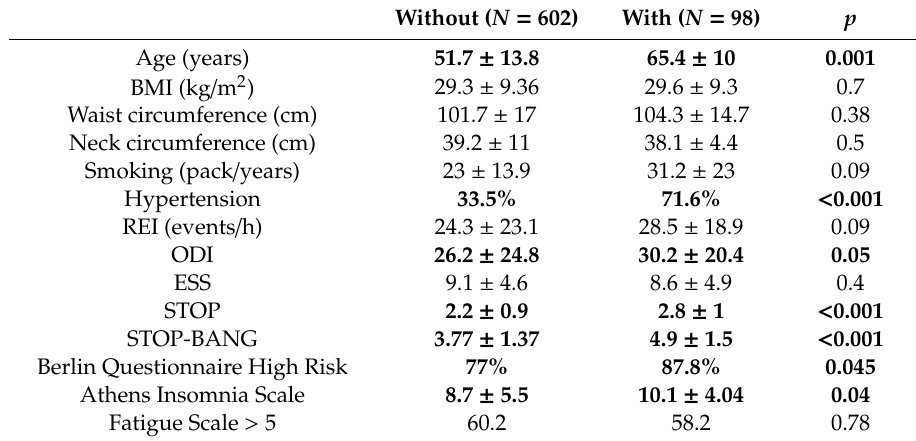
Table 6. Di ff erences between the characteristics of patients with / without cardiovascular disease.